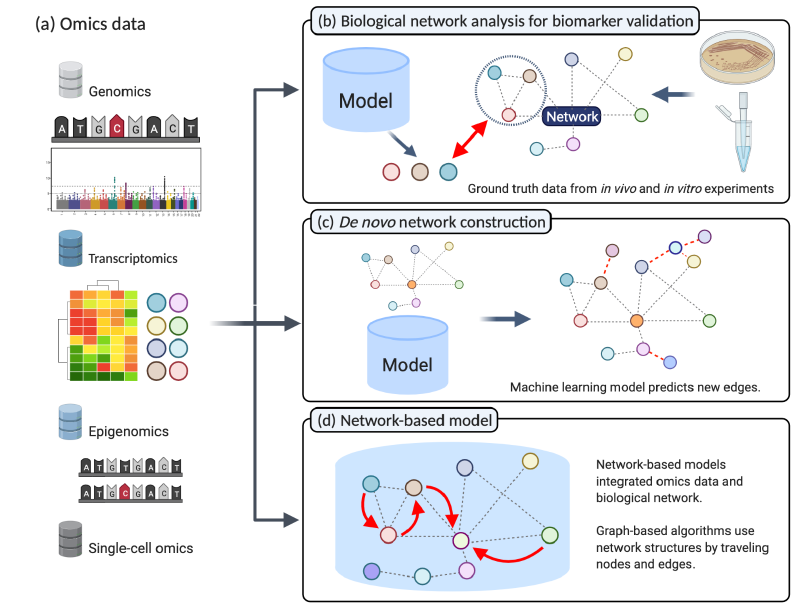
Figure 2. ( a ) A multitude of different types of data is produced by next-generation sequencing, for instance, in the fields of genomics, transcriptomics, and epigenomics. ( b ) Biological networks for biomarker validation: The in vivo or in vitro experiment results are considered ground truth. Statistical analysis on next-generation sequencing data produces candidate genes. Biological networks can validate these candidate genes and highlight the underlying biological mechanisms (Section